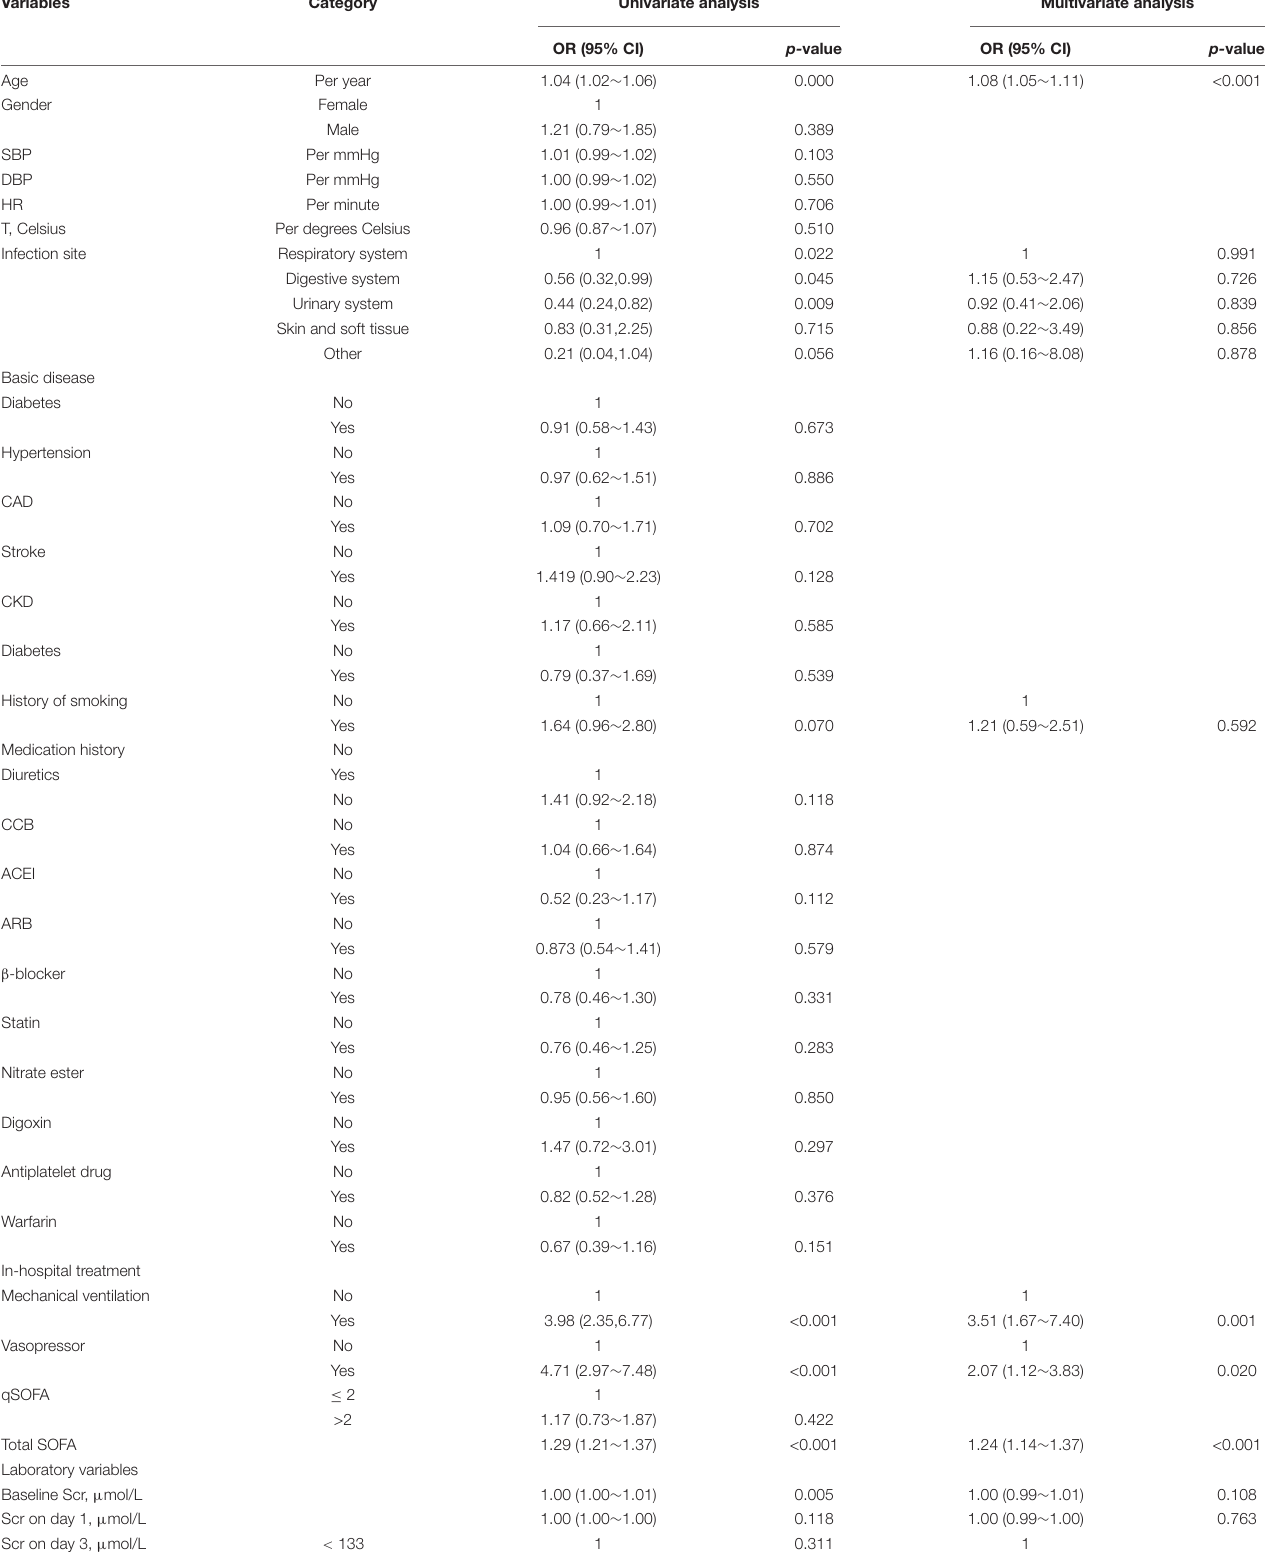
TABLE 2 | Univariate and multivariate analyses for prognostic